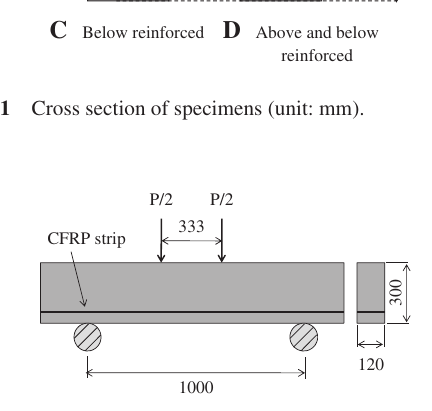
Figure 2 Four point bending test (unit: mm)